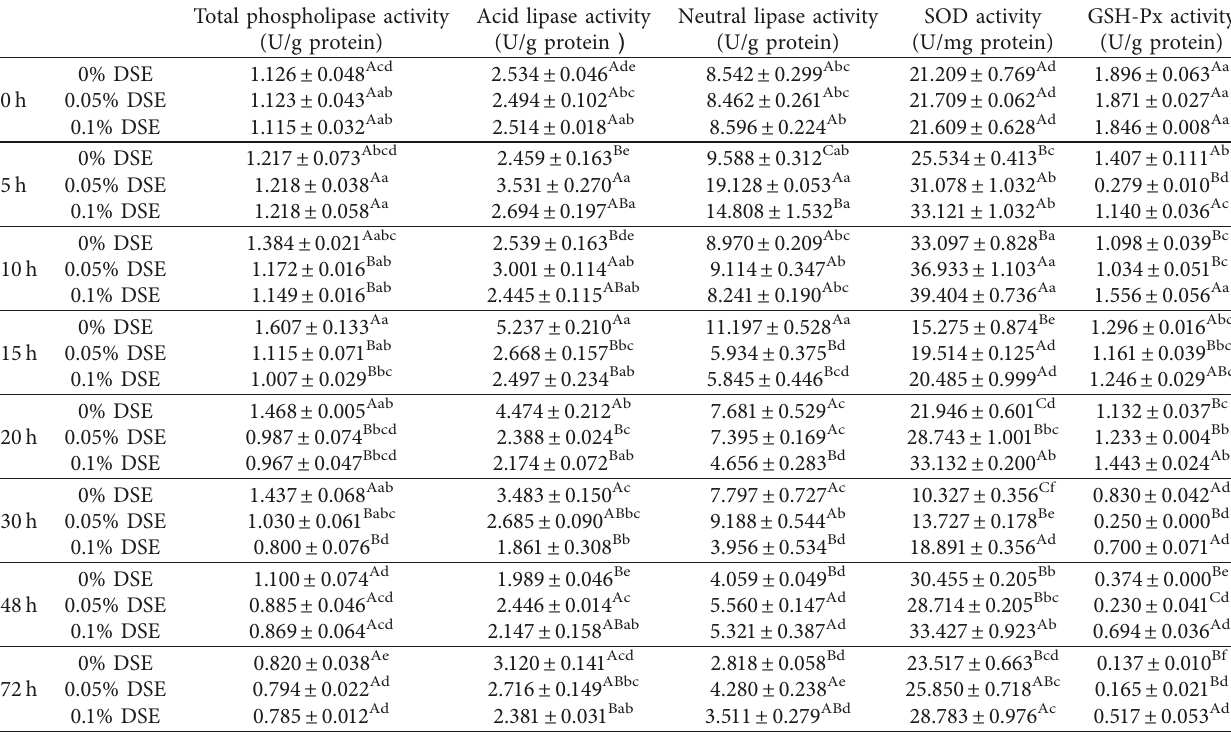
Table 2: Changes of total phospholipase, acid lipase, neutral lipase, and SOD and GSH-Px activities in Cantonese sausage processing.